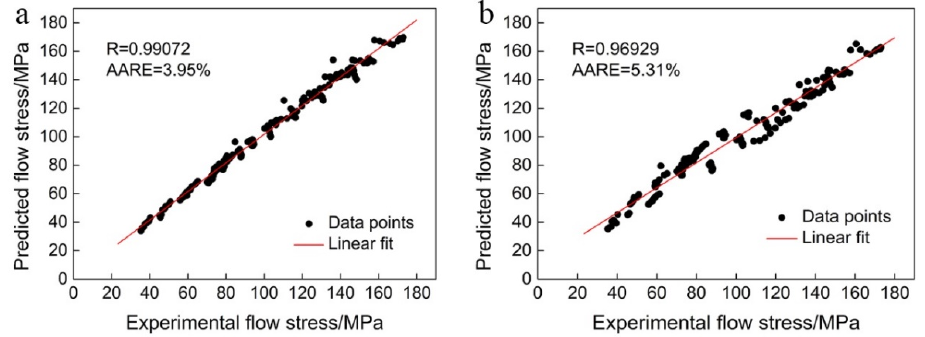
Figure 6. Correlations between the experimental and predicted flow stresses by models ( a ) with and ( b ) without strain compensation.